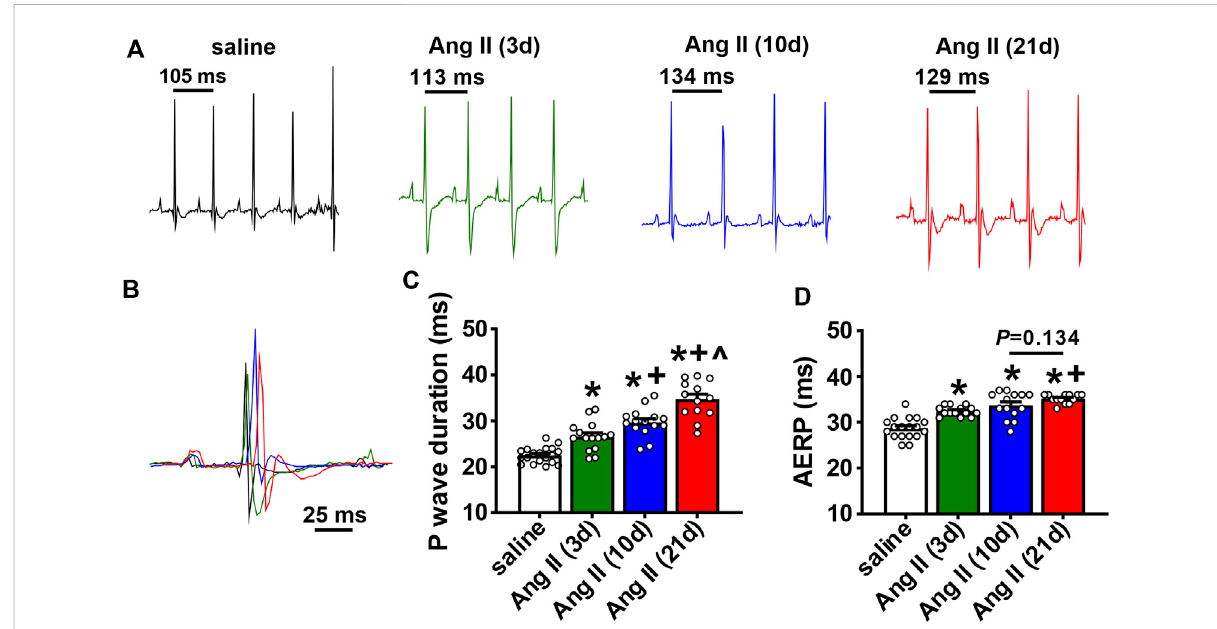
FIGURE 3 Time course of the effects of Ang II on atrial electrophysiology (A) Representative ECGs in mice infused with saline for 21 days or Ang II for 3, 10 and 21 days. (B) Overlay of ECGs showing a single beat in saline infused mice and mice infused with Ang II for 3, 10 and 21 days. Colors are as shown in panel (A) (C) Summary of P wave duration in mice infused with saline or Ang II for 3, 10 and 21 days. (D) Summary of AERP in mice infused withsalineorAngIIfor3,10and21 days.Forpanels (CandD) * p < 0.05vssaline, + p < 0.05vsAngII(3 days), ^ p < 0.05vsAngII(10 days)byone- way ANOVA with a Holm-Sidak posthoc test; n =19 mice for saline, 15 for Ang II (3 days), 15 for Ang II (10 days) and 13 for Ang II (21